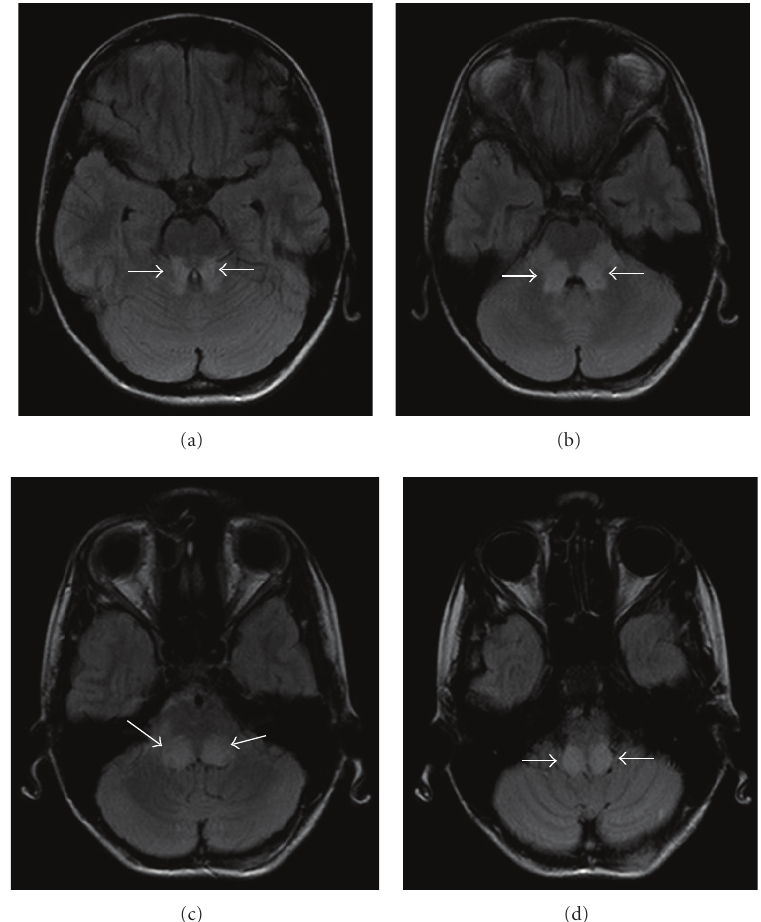
Figure 1: Axial fluid attenuation recovery (FLAIR) MR images show symmetric abnormal hyperintensity in the cerebellar tonsils and inferior, middle, and superior cerebellar